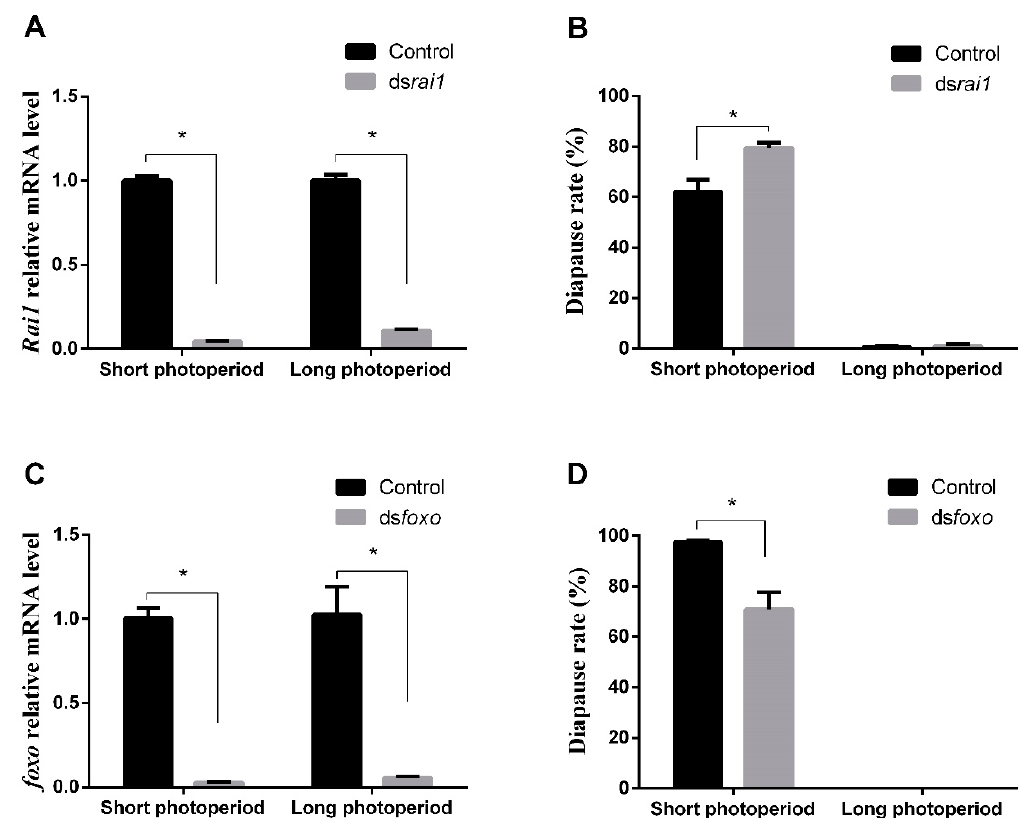
Figure 4. ( A ) RNAi e ffi ciency verified in the whole body of adult females after injecting dsRNA of rai1 under both long and short photoperiods. ( B ) Diapause rate detected after injecting dsRNA of rai1 under both long and short photoperiods. ( C ) RNAi e ffi ciency verified in the whole body of adult females after injecting dsRNA of foxo under both long and short photoperiods. ( D ) Diapause rate detected after injecting dsRNA of foxo under both long and short photoperiods. Numbers of replications were set as three for each treatment. Values were reported as mean ± SE. * Indicates an error probability of p < 0.05 using Student’s t -test.